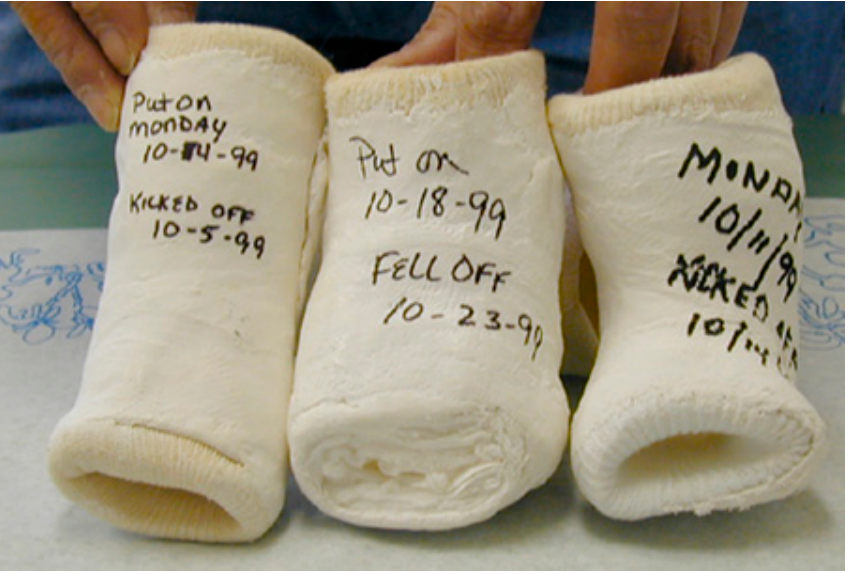
Figure 3. Clinical picture showing below knee casts with excessive padding resulting in cast slip- page (to be avoided). (to be